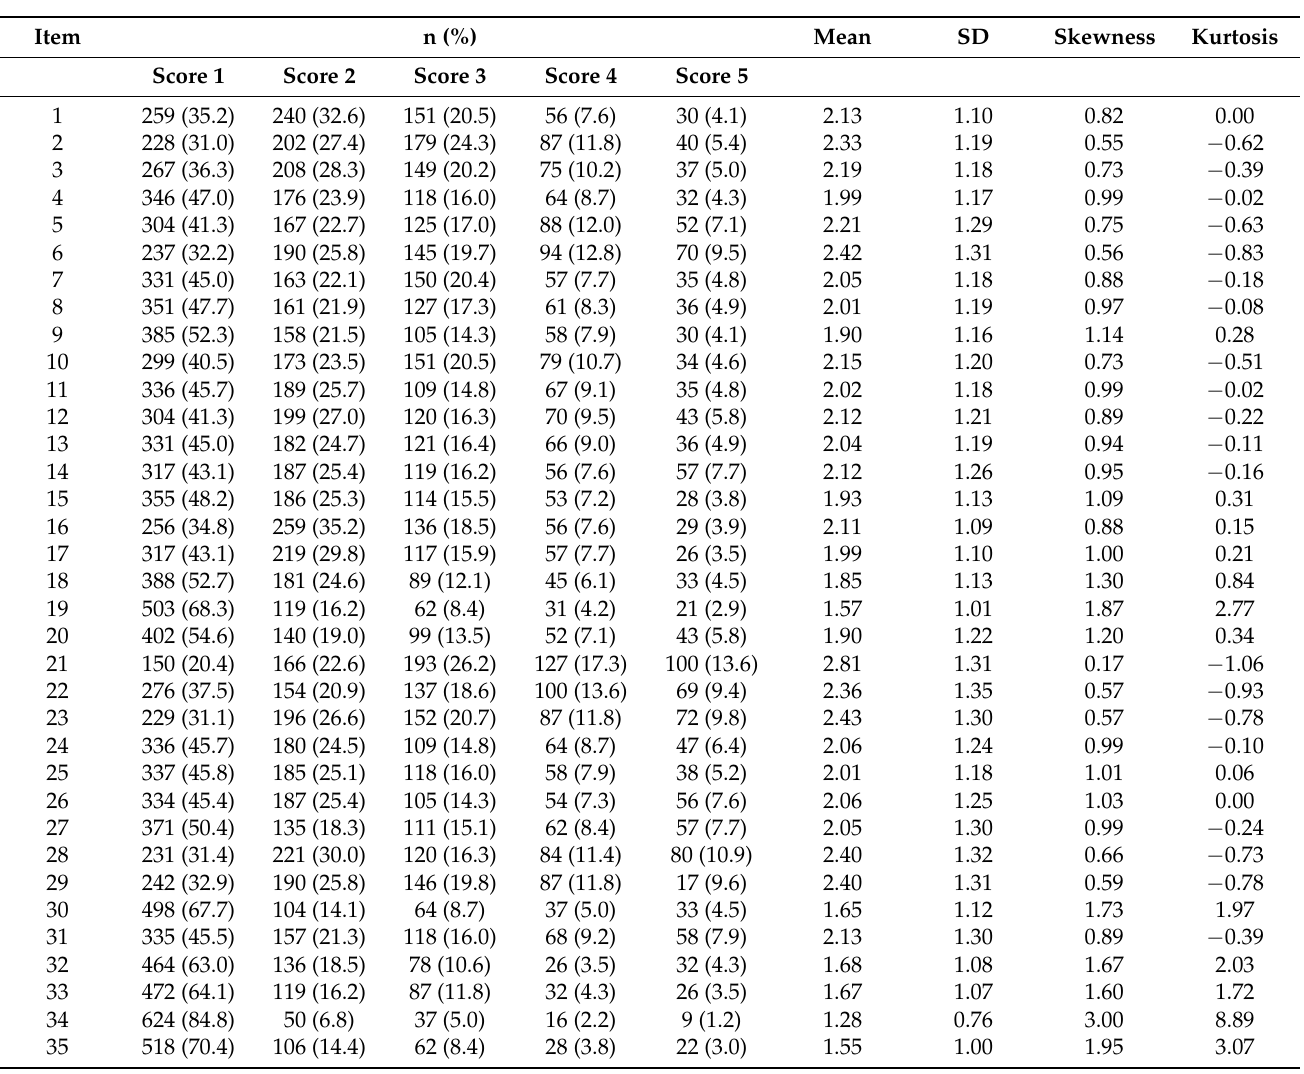
Table 2. Item properties of the Gay Community Stress Scale (N = 736).